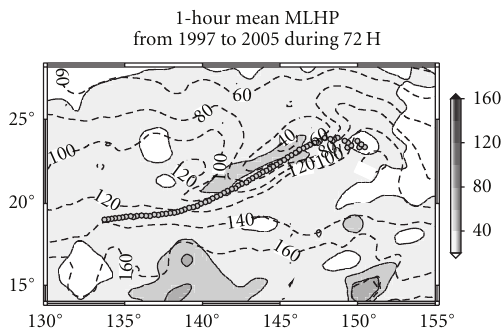
Figure 7: Scatter diagram of central pressure (hPa) versus accumu- lated MLHP (AMLHP) during 72h (kJcm − 2 ) from 1997 to 2005. The numbers by each point indicate which year’s daily oceanic reanalysis data on 12 July were used by